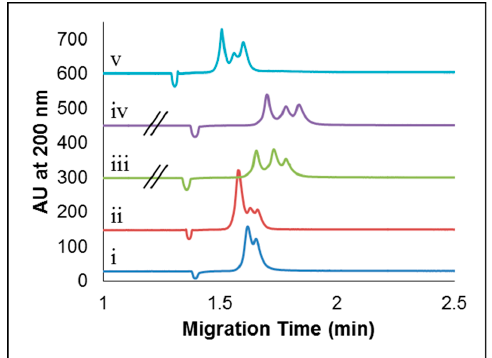
Figure 3. Abbreviated range of CDs concentrations tested with a mixture of apo- and holo-Tf (25 µM each). Concentrations of CDs shown are ( i ) 2 µg/mL, ( ii ) 10 µg/mL, ( iii ) 35 µg/mL, ( iv ) 100 µg/mL, and ( v ) 500 µg/mL. Electropherograms are vertically offset for clarity. A volume of 5 nL (2.1 sec at 45 mbar) was injected and 20 kV was applied. The separation occurred on an Agilent G1600A CE coupled with a DAD UV/Vis Detector at 25 °C on a 50 µm i.d. capillary with an effective length of 24 cm and a total length of 32.5 cm.